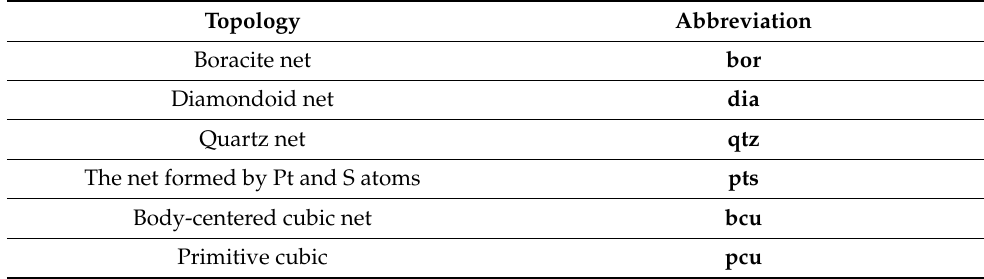
Figure 10. The schematic representation of the nbo topology [35]. Table 1. Topologies with their abbreviated